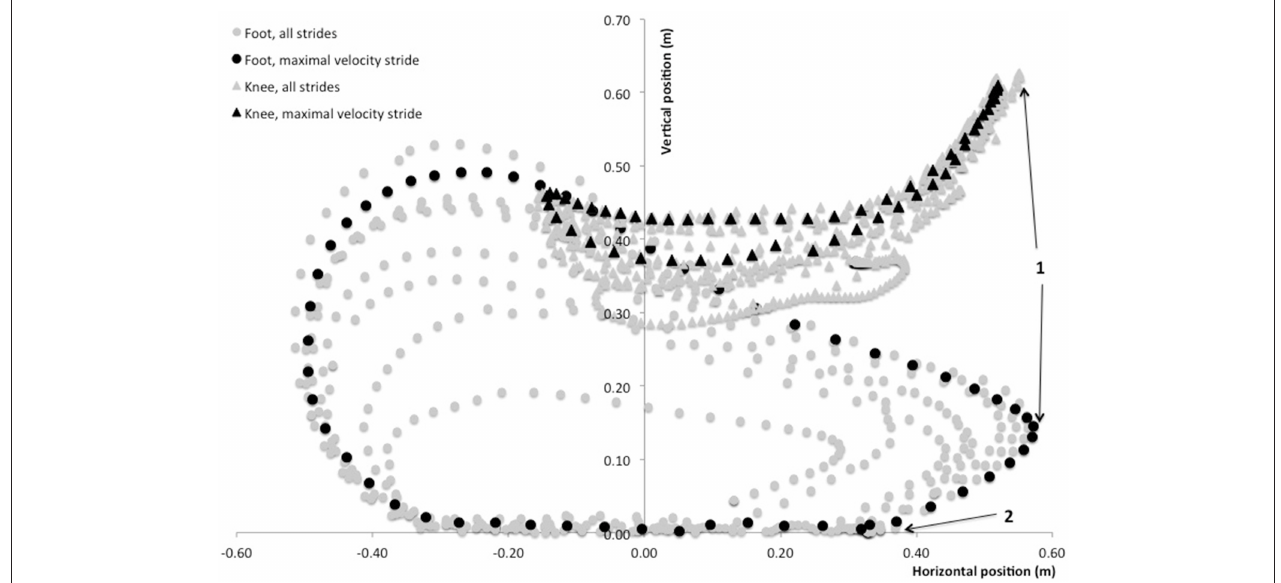
FIGURE 2 | Typical foot (circles) and knee (triangles) path diagram during an entire sprint treadmill acceleration of a rugby player. The stride at maximal running velocity (9th stride in this trial) is shown with black circles and triangles. Positions are displayed with reference to the treadmill belt frame (vertical axis) and the subject’s resting standing position was used for calibration (femoral marker in the horizontal axis). Position 1 indicates the maximal forward position of the foot and knee as retained for analyses. Position 2 indicates the initial foot-ground contact. The path of the foot marker from position 1 to position 2 is considered as the “pawing” backward motion of the foot at the end of the swing phase.